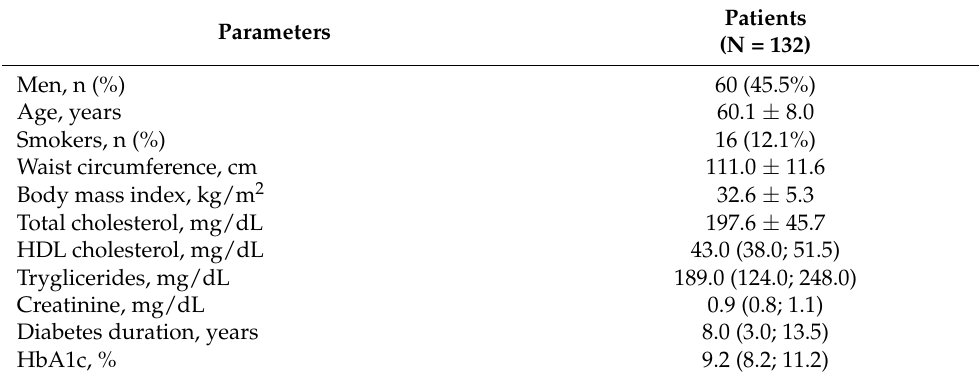
Table 1. Clinical and laboratory characteristics of the study